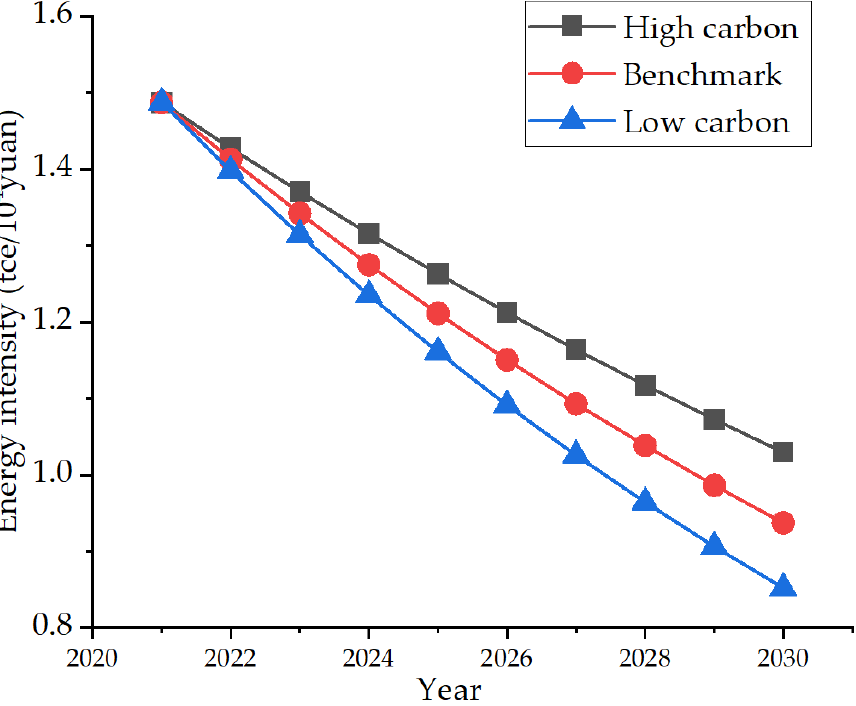
Figure 9. Three energy intensity development scenarios .